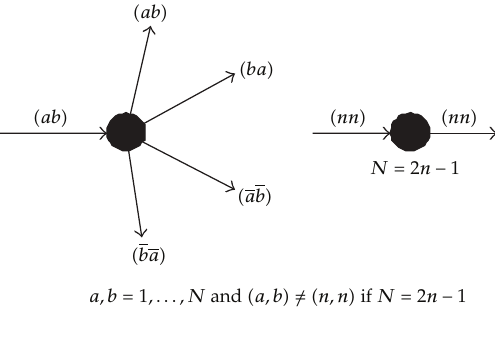
Figure 1: Scattering